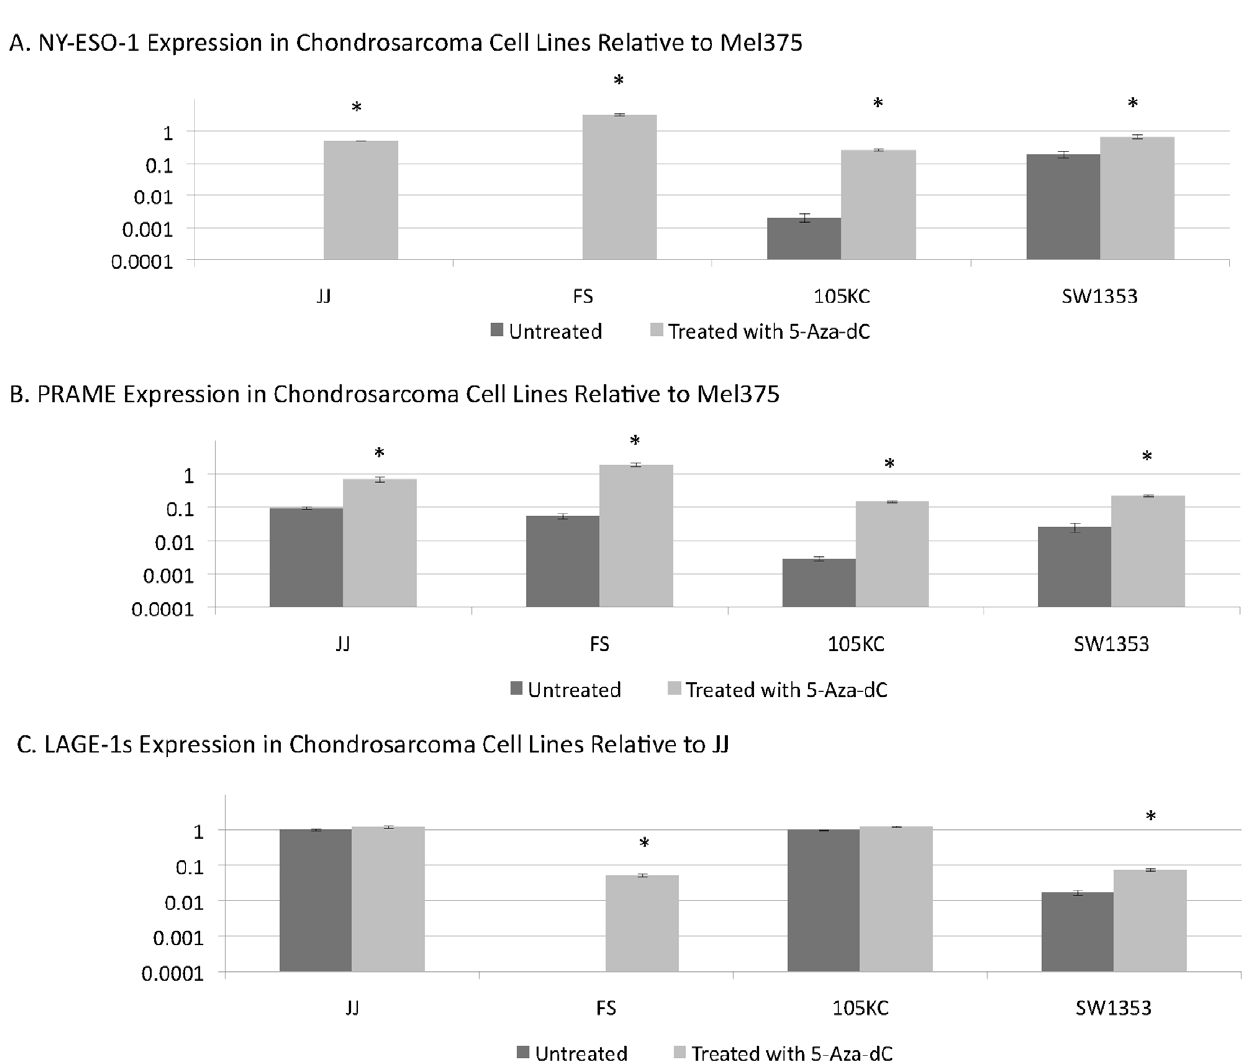
Figure 1. qRT-PCR expression in the chondrosarcoma cell line FS, JJ, 105KC and SW1353 with and without treatment using 5-Aza- dC for 48 hours. Treated cells rested 48 hours prior to RNA extraction. Primers are listed in Table 1. Data is presented relative to a reference sample: either Mel375 for NY-ESO-1 and PRAME or JJ for LAGE-1s normalized to GAPDH. Asterisk indicates statistical significance of p , 0.05. Note that all CT antigens were significantly increased following 5-Aza-dC in all chondrosarcoma lines with the exception of LAGE-1s expression in the 105KC and JJ. These cell lines both strongly expresses LAGE-1s without treatment and were not changed significantly by 5-Aza-dC. The JJ cell line is not displayed in 1C as it is used for a reference value for LAGE-1s. Error bars describe variation between multiple values within a single experiment. Experiments were repeated at least three times to ensure reproducibility.